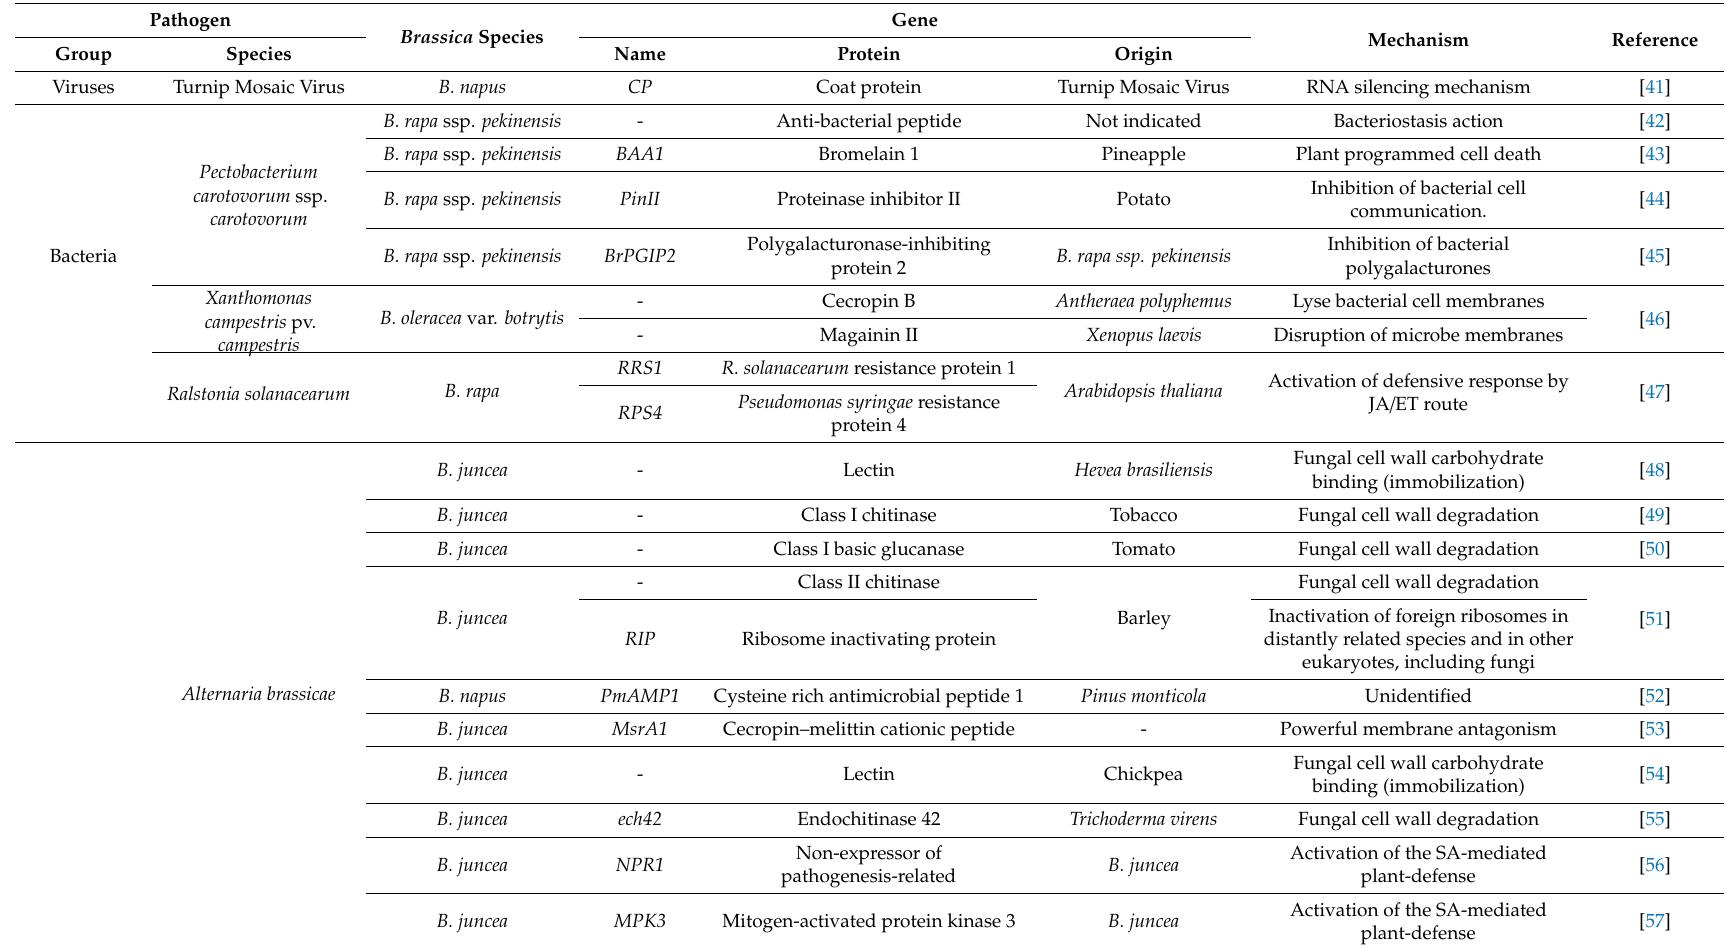
Table 1. Transgenic Brassica crops against